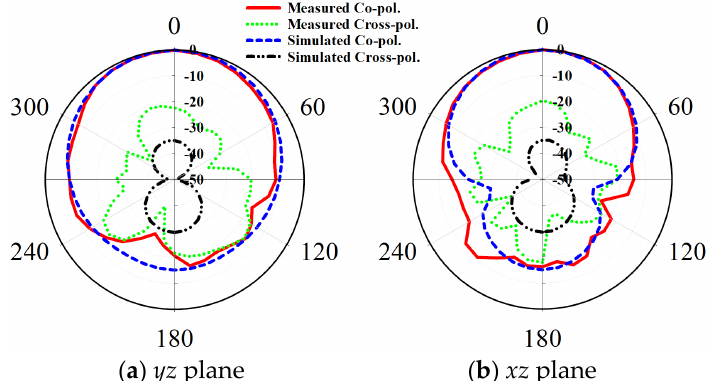
Figure 12. Normalized radiation patterns of aperture-fed antenna (868 MHz).